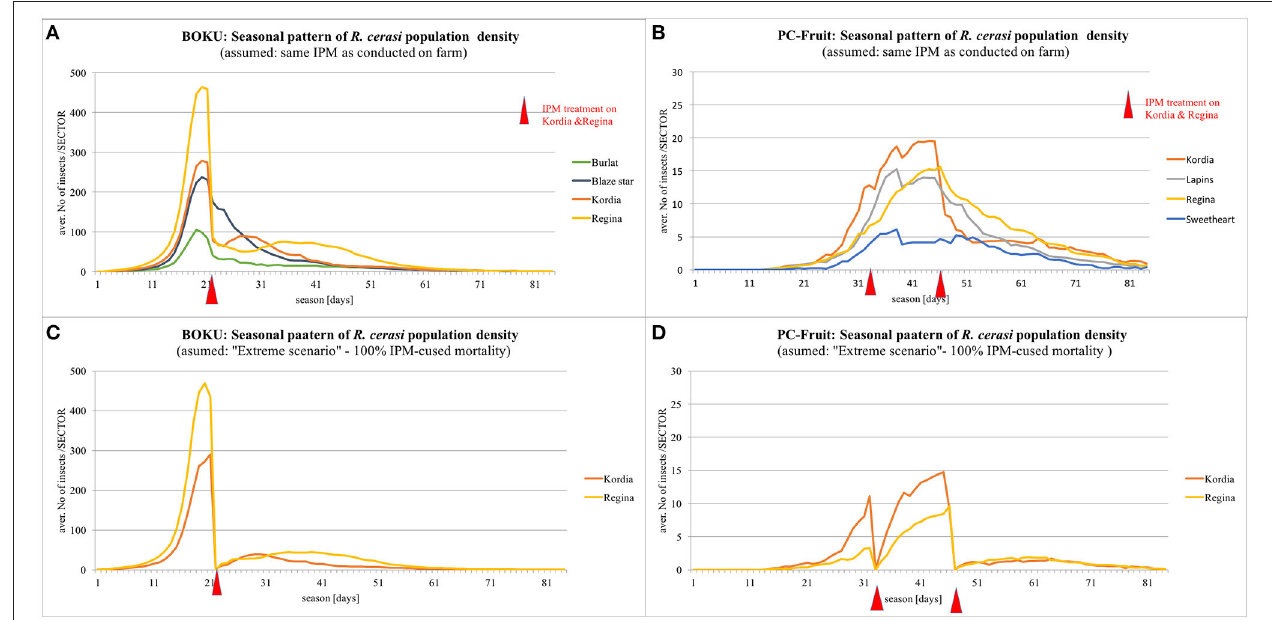
FIGURE 6 | Reduction and resurgence of R. cerasi population after IPM